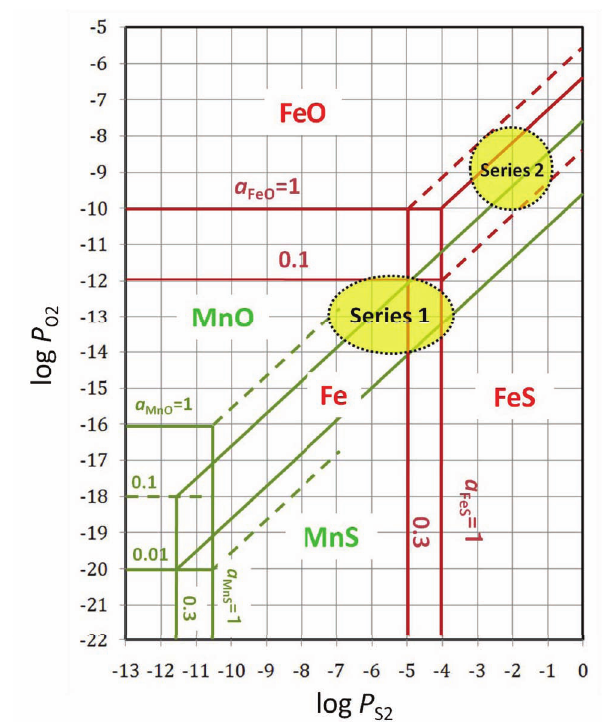
Figure 4. Fe and Mn speciation diagram with respect to and log P S for series 1 and 2 at 1673 K. log P O 2 2